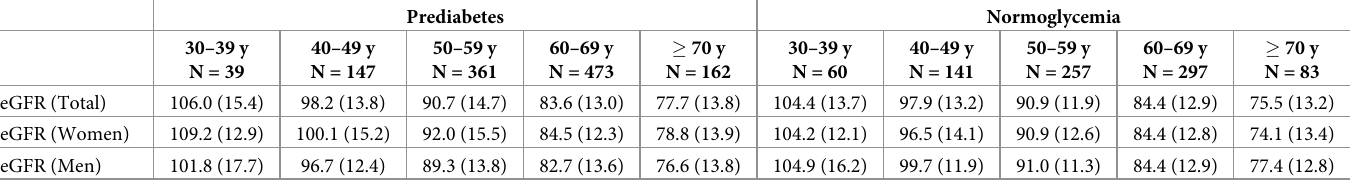
Table 1. Estimated glomerular filtration rate (eGFR) according to age and sex of all participants at baseline by glucose metabolism status. Prediabetes